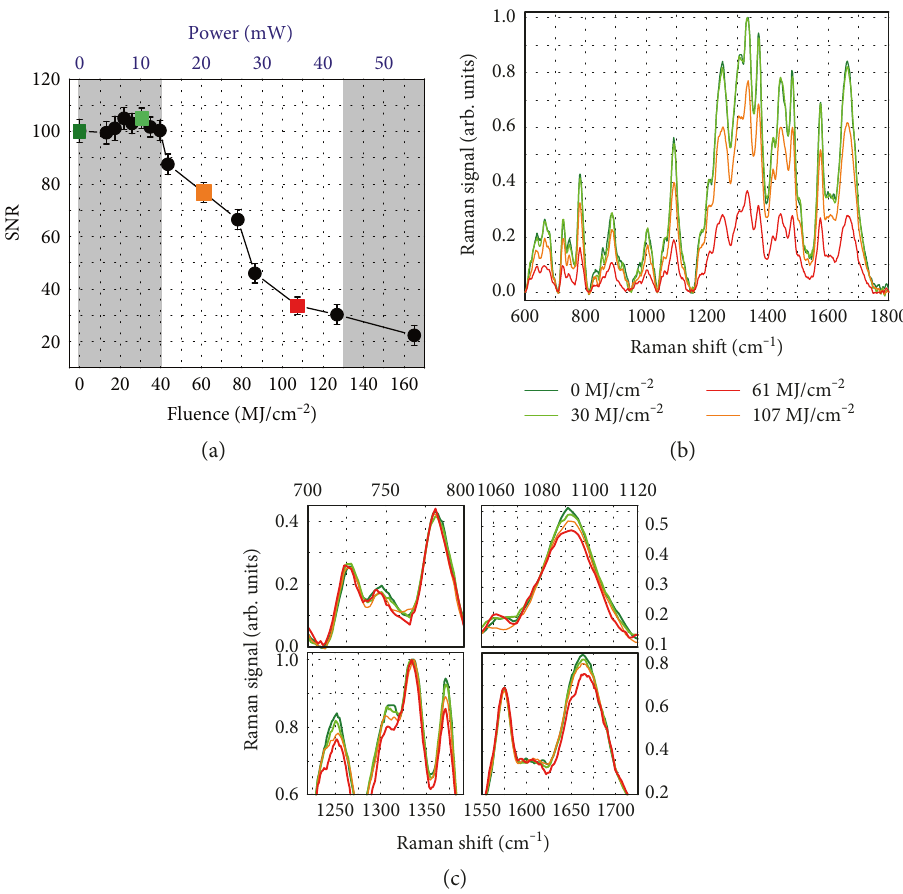
Figure 9: (a) Raman signal-to-noise ratio (SNR) measured as the ratio of the maximum Raman peak intensity at 1335 cm − 1 to the standard deviation of the region between 1750 and 1800 cm − 1 as function of the applied green light irradiation levels between 0 and 165 MJ/cm 2 . (b) Representative spectra relative to the laser fl uences of 0, 30, 61, and 107MJ/cm 2 are shown. (c) Zoom of the spectra in the DNA and protein regions